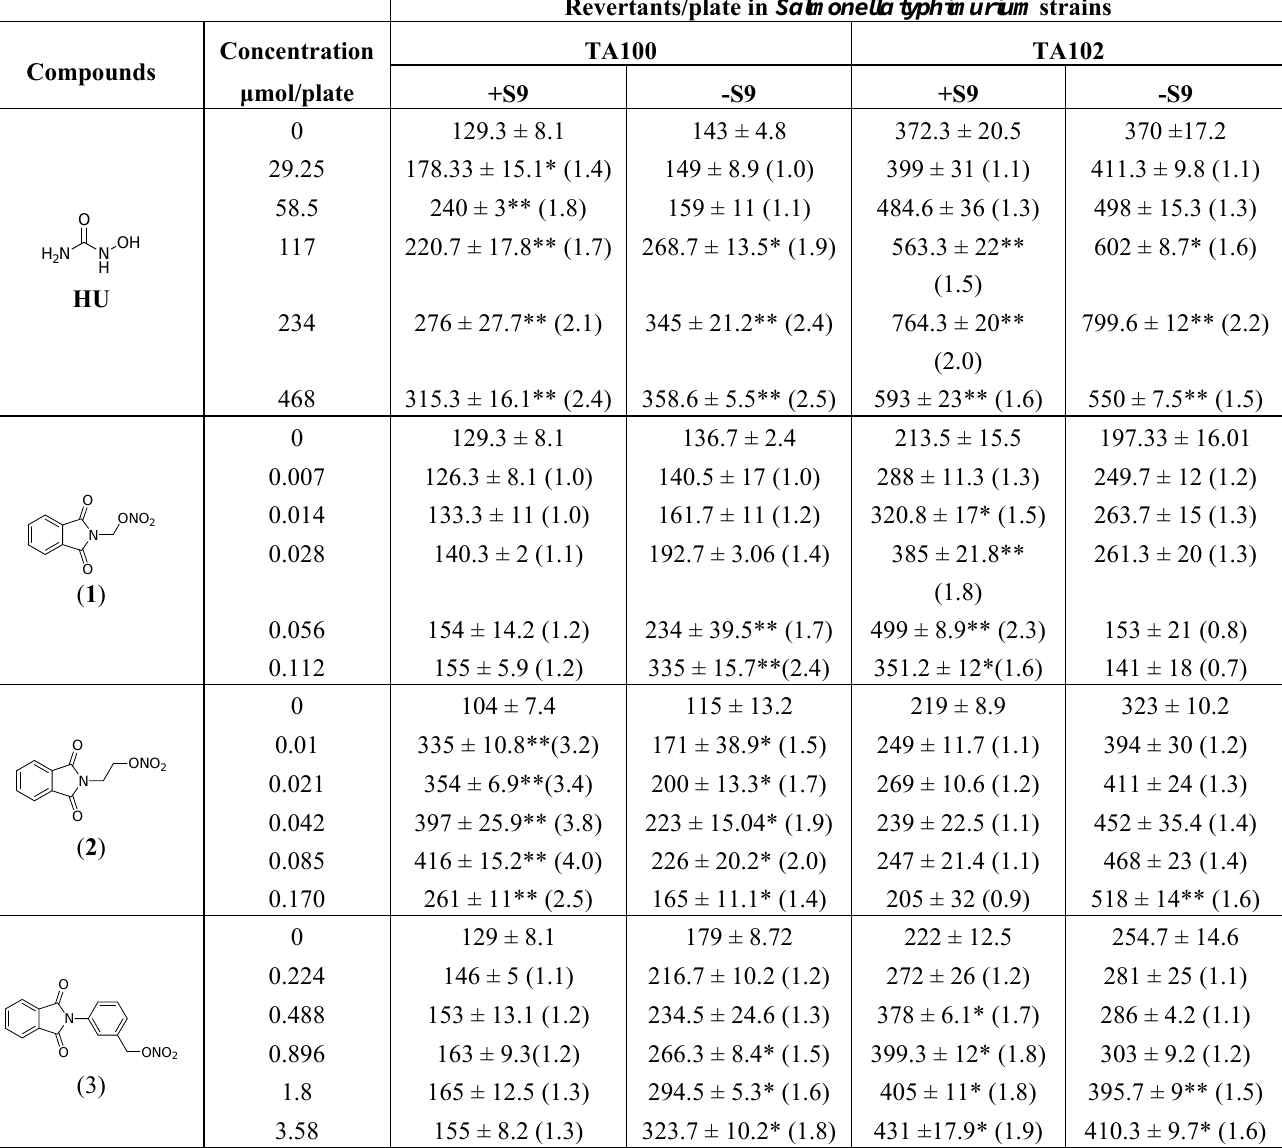
Table 1. Mutagenic activity expressed as the mean and standard deviation of the number of revertants/plate in bacterial strains TA100 and TA102 exposed to compounds (1–6) and HU, at various doses, with (+S9) or without (-S9) metabolic